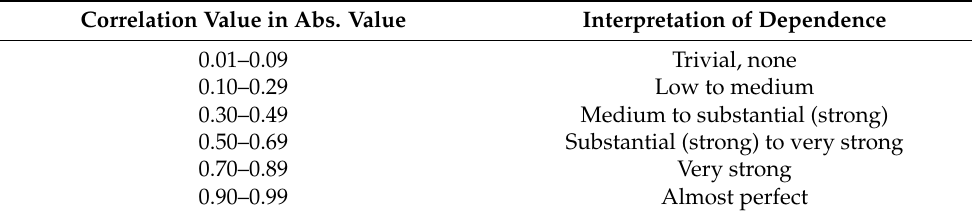
Table 1. Correlation values in absolute value and interpretation of the degree of dependence. Correlation Value in Abs.